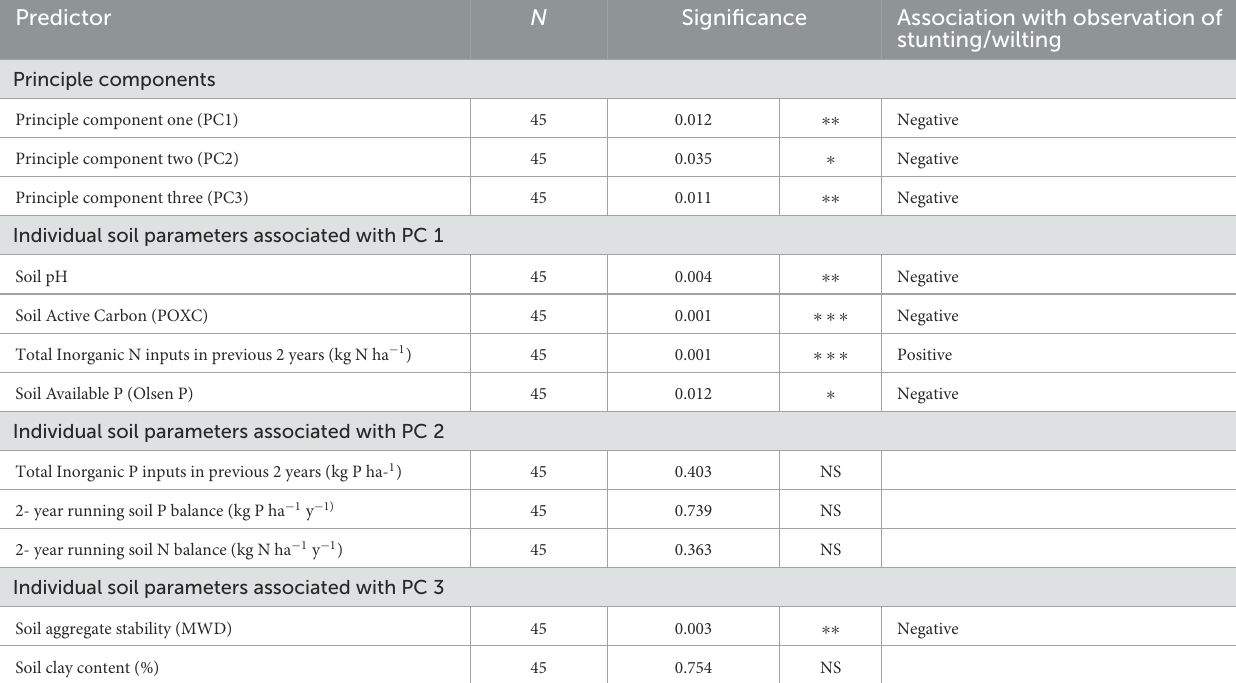
TABLE 5 Logistic regressions assessing the relationship of soil parameters and soil nutrient management predictors, with a synthetic variable summarizing observations of stunting and wilting in beans (farmers observe stunting or wilting vs. do not observe), in Narumu Ward, Kilimanjaro Region,